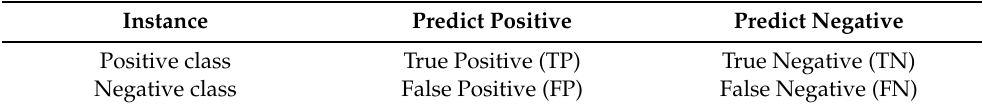
Table 2. Different cases of